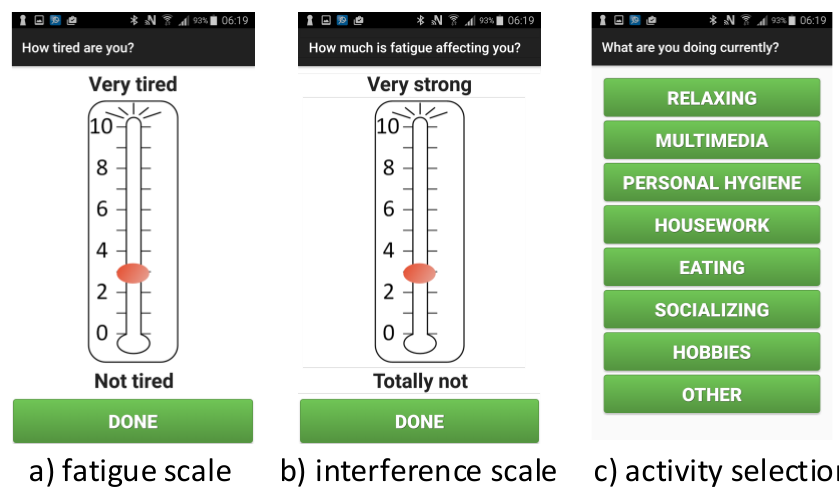
Figure 2. Design ( a ) of the visual analogue scale to rate the perceived fatigue and ( b ) of the VAS to rate the perceived interference of fatigue and ( c ) of the selection of the currently performed activity (English translations from German original).